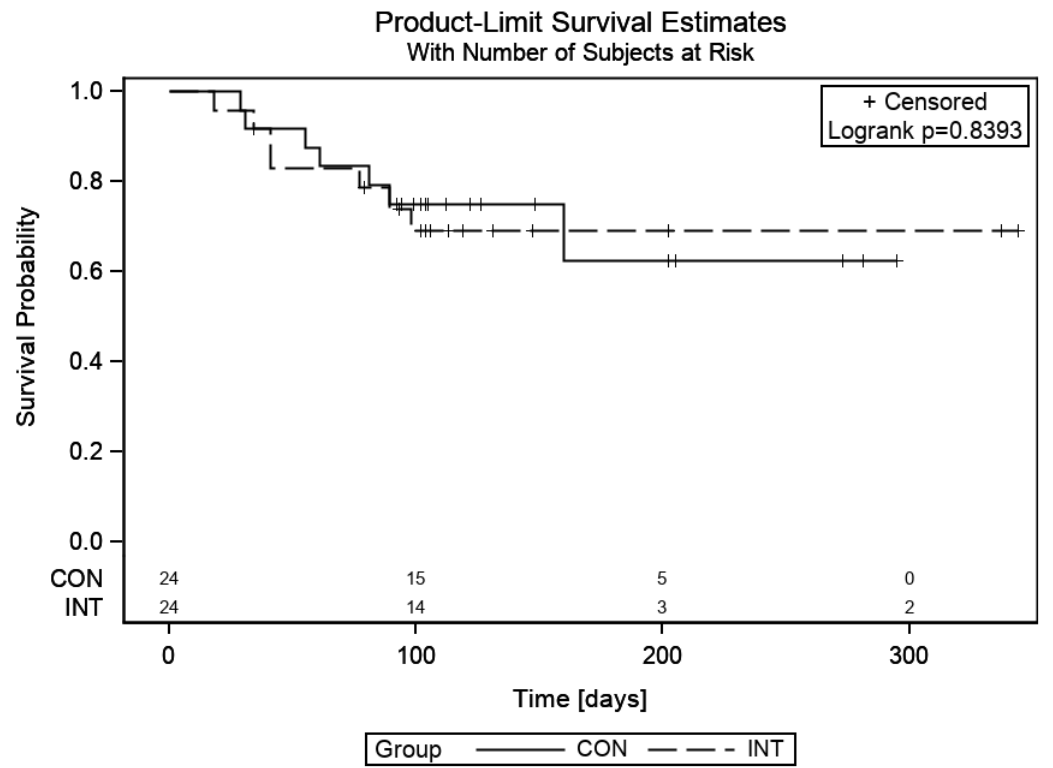
Figure 2. Overall survival of both arms, time in days.